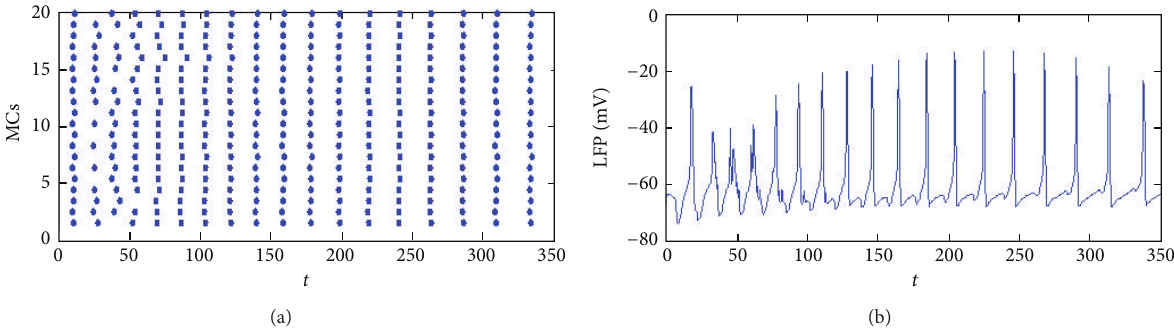
= 0.1 . (b) LFP of twenty MCs when 𝑔 GABA